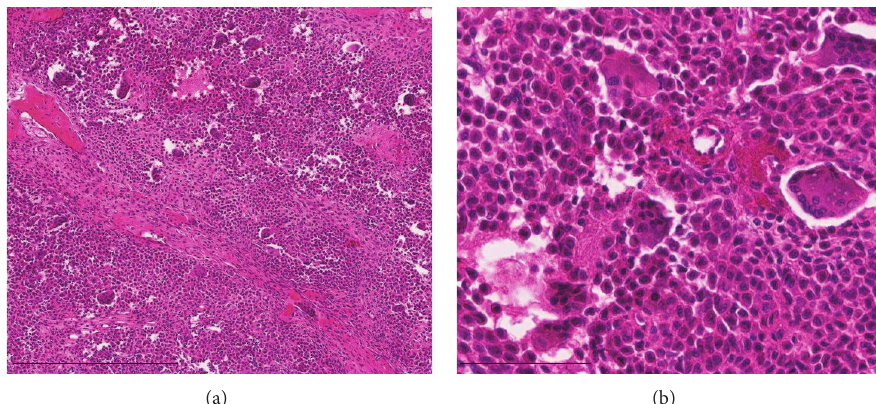
Figure 3: Low (a) and high (b) magnifications of hematoxylin and eosin staining. Scale bars indicate 500 𝜇 m (a) and 100 𝜇 m (b), respectively.